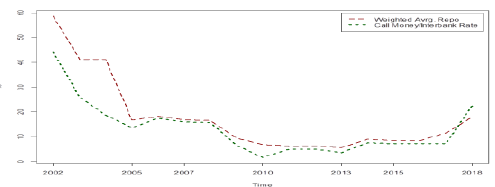
Figure 4. Representative interest rates (Annually) Source: CBRT, 2018